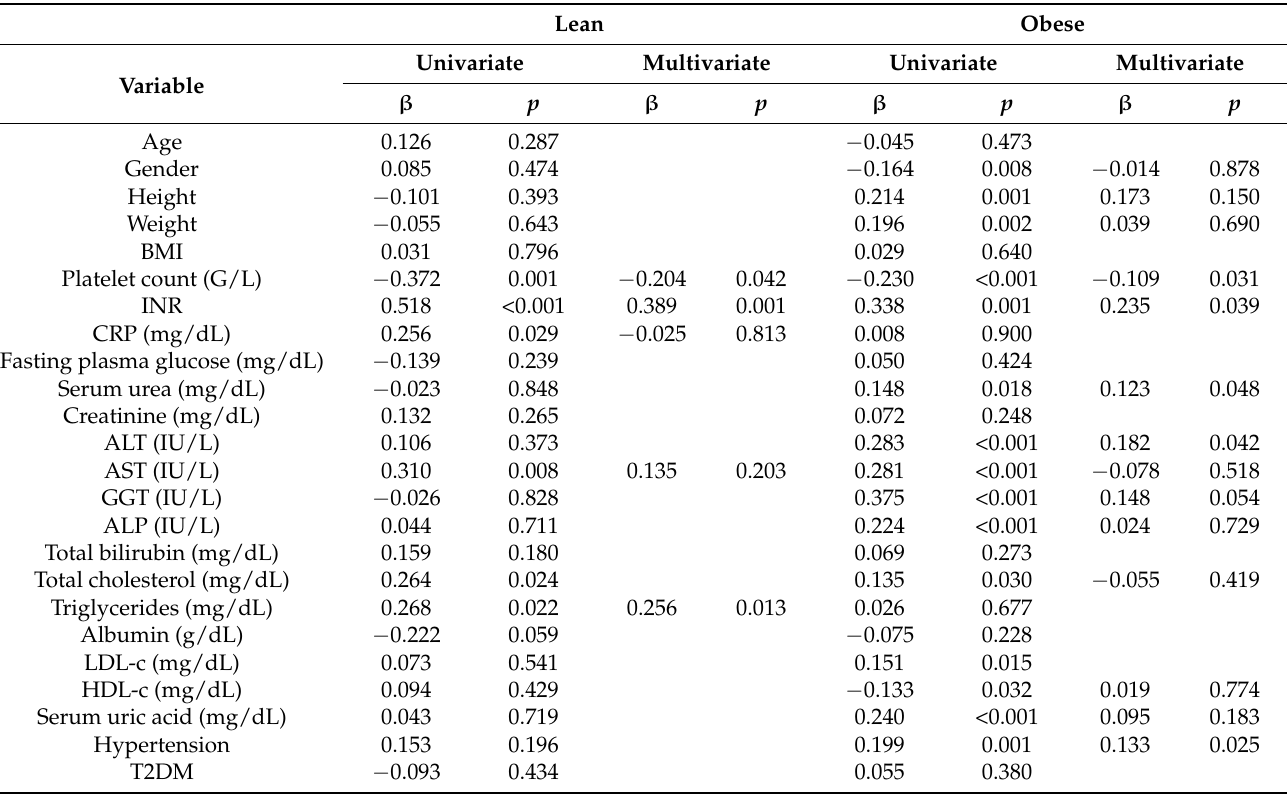
Table 3. Factors associated with advanced liver fibrosis using univariate and multivariate linear regression analyses. Lean Obese